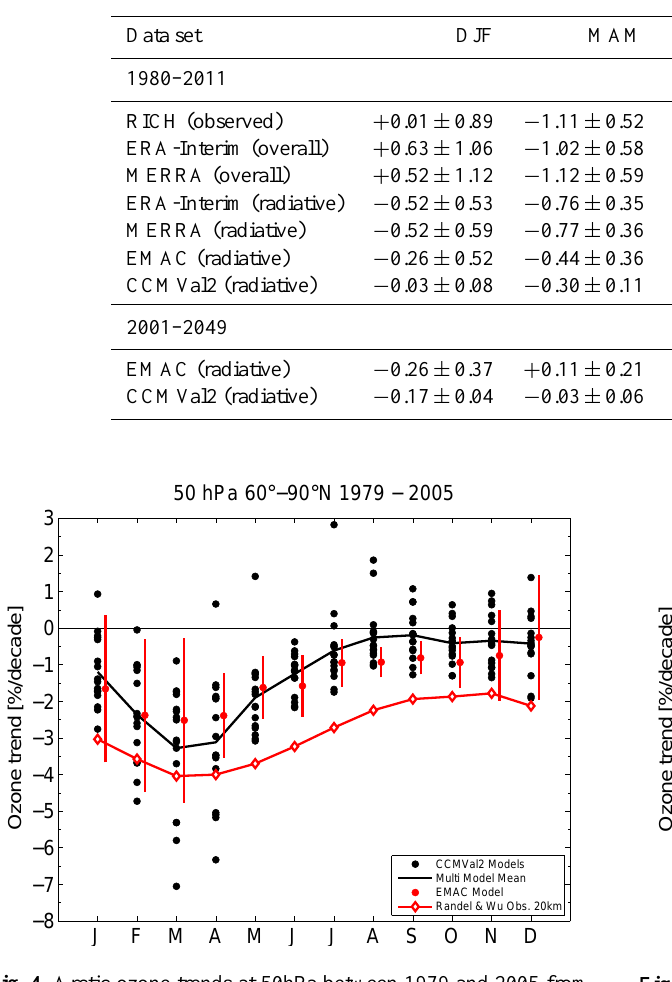
Table 2. Arctic temperature trends (60–90 ◦ N) at 50hPa from RICH adjusted radiosonde data, ERA-Interim and MERRA reanalyses and model simulations. Seasonal temperature trends (overall) are shown for RICH, ERA-Interim and MERRA. The radiative contribution to the temperature trend is shown for ERA-Interim, MERRA, CCMVal2 multi-model mean and our EMAC simulation. All values are in Kdecade − 1 with a 2 σ error range.